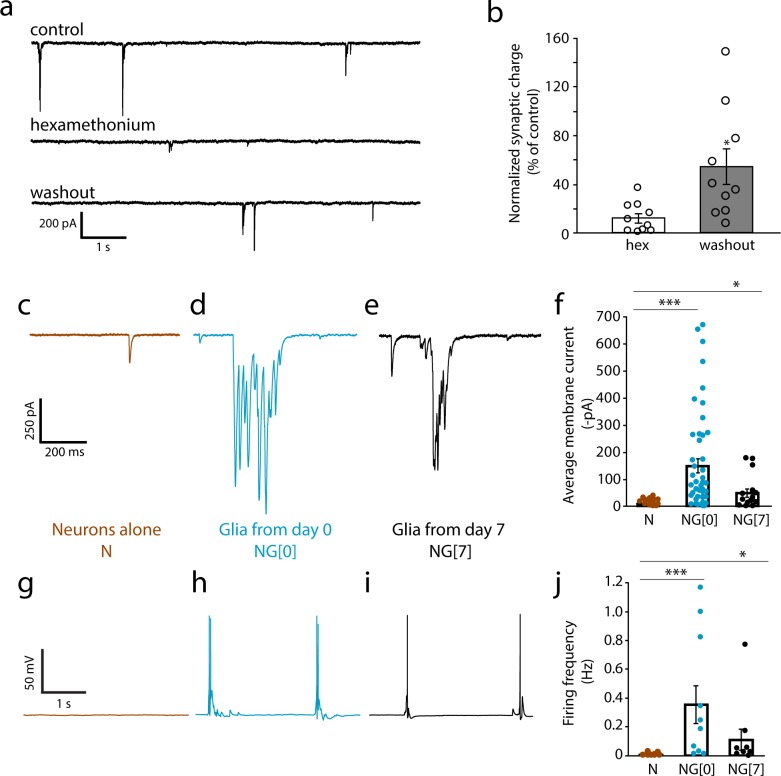
Satellite glial cells increase spontaneous activity of cultured sympathetic neurons.(a) Representative traces of spontaneous activity of neurons held in voltage-clamp at -60 mV, without hexamethonium, with 100 μM hexamethonium and after washout. (b) Average synaptic charge, normalized to control, for neurons treated with 100 μM hexamethonium (hex) and following washout (n = 10 cells per condition; paired t-test; *p<0.05). (c-j) Neurons were cultured for 14 days either alone (c, g) or in the presence of satellite glial cells starting from day 0 (d, h) or day 7 (e, i). NGF (5ng/ml) was included in all culture conditions to promote neuronal survival. (c-e) Representative voltage clamp traces showing that co-culture with satellite glial cells for the 14 days culture period, or for the last 7 days of the period increases current flow. (f) Quantification of synaptic activity. Total synaptic charge, defined as the area above the curve for neurons grown in the absence (Neurons alone, N) or presence of satellite glial cells for 14 days (NG[0]) or the last 7 days of the culture period (NG[7]), was quantified and average synaptic charge per 10 s duration was calculated. Plotted average membrane current values were quantified as averaged synaptic charge normalized to 1 ms duration. Therefore, the value of the average membrane current of e.g. -400 pA is equivalent to an average synaptic charge of 4 nC (n≥ 15 cells, Mann-Whitney U test, ***p<0.001, *p<0.05) (g-i) Representative current clamp traces showing that glial cells increase spontaneous firing in cultured sympathetic neurons. (j) Quantification of neuronal firing rate in the absence (N) or presence of satellite glial cells for 14 (NG[0]) or 7 (NG[7]) days. (n≥10 cells, Mann-Whitney U test ***p<0.001, *p<0.05). Bars represent mean ± s.e.m.; dots represent data for individual cells.